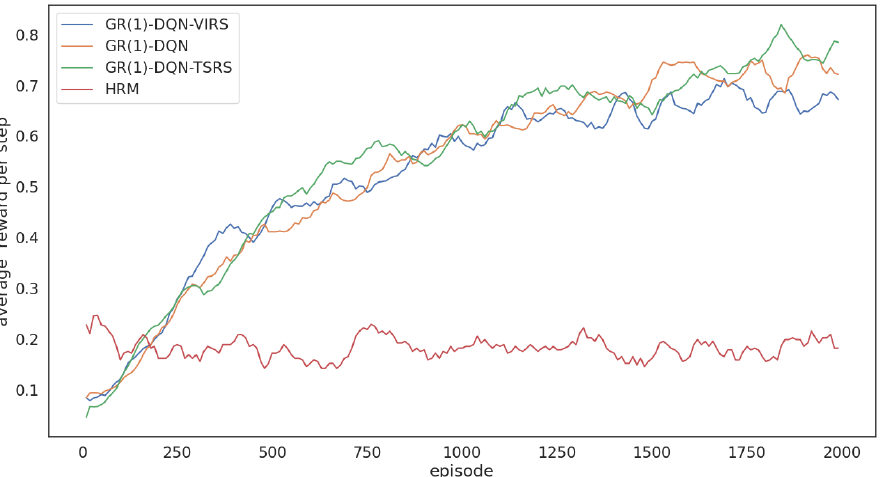
Figure 7. Comparison of learning curves for multi-task reinforcement learning algorithms with ϕ 3 under the same stochastic